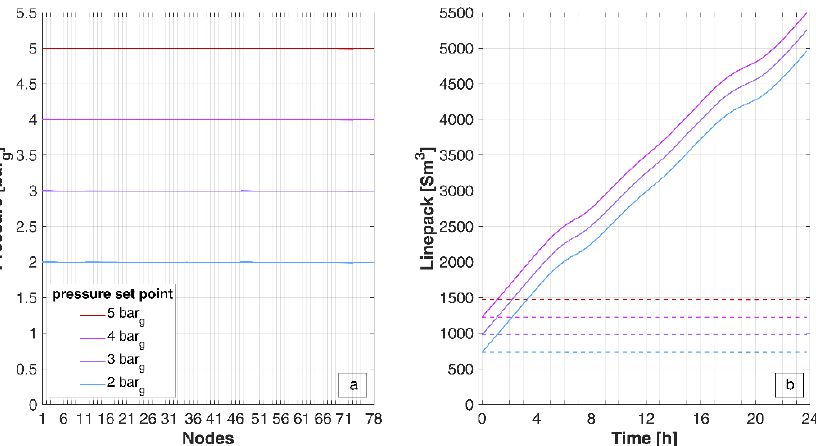
Figure 6. ( a ) Nodal pressure sequence throughout the network for the different set point pressures; ( b ) evolution of the linepack for the different set point pressures for both the non-injection case (dashed lines) and the injection case (solid lines); the red dashed line corresponding to the linepack at 5 bar g is to be considered as the maximum possible linepack.